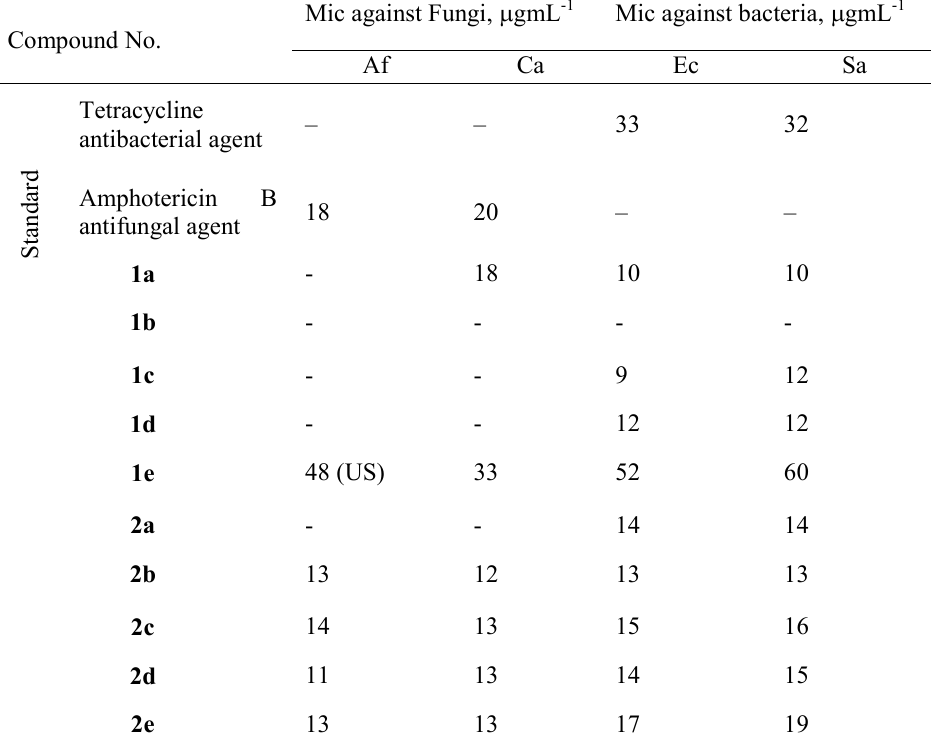
Table 1. Antifungal activity data and antibacterial